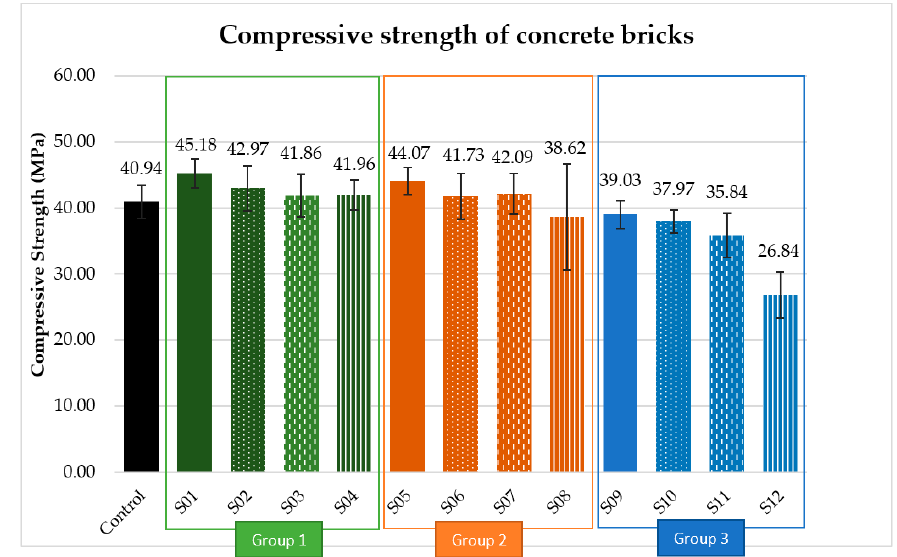
Figure 5. The compressive strength of concrete bricks.